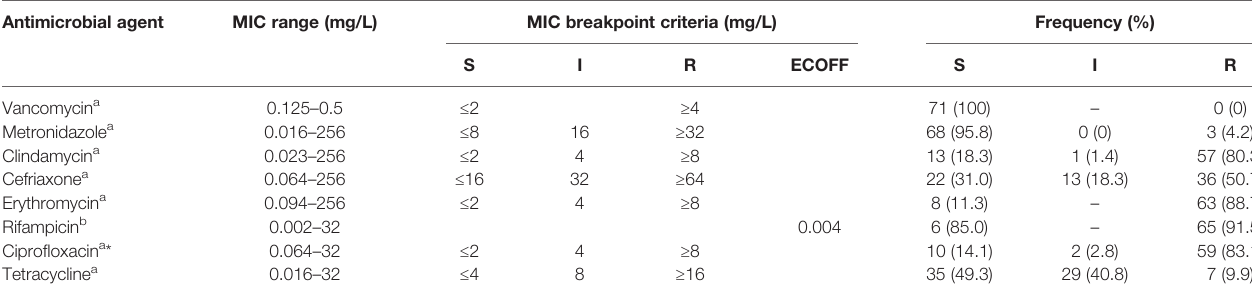
TABLE 2 | Antimicrobial susceptibility pattern of C. dif fi cile isolates (n = 71). Antimicrobial agent MIC range (mg/L) MIC breakpoint criteria (mg/L)